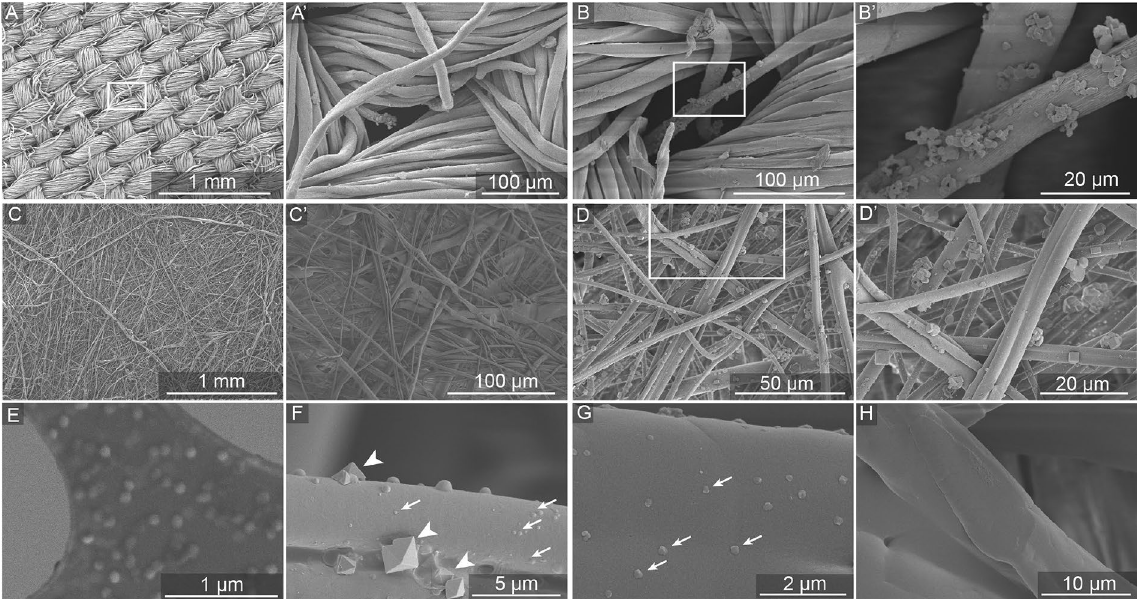
Figure 6. Localization of NaCl and InViS particles in textile community masks after filtration efficiency tests. Micrographs after filtration efficiency test with NaCl show: ( A ) the outermost woven layer of a textile community mask, ( B ) a pore of the outermost woven layer after the filtration test with NaCl particles, ( C ) the inner meltblown fitration layer and ( D ) salt particles filtered by the inner meltblown filtration layer. ( A’ – D’ ) represent magnifications of the white quadrant in ( A – D ) (except C’ which is from another area not visible in C ). Micrographs after filtration efficiency test with InVIS show: ( E ) SEM imaged of InViS on Transmission Electron Microscope (TEM) grid sample holder, ( F ) and ( G ) the inner meltblown filtration layer (salt crystals and InViS particles are highlighted with arrow heads and arrows, respectively). ( H ) is a reference fiber from the inner meltblown layer which did not undergo filtration